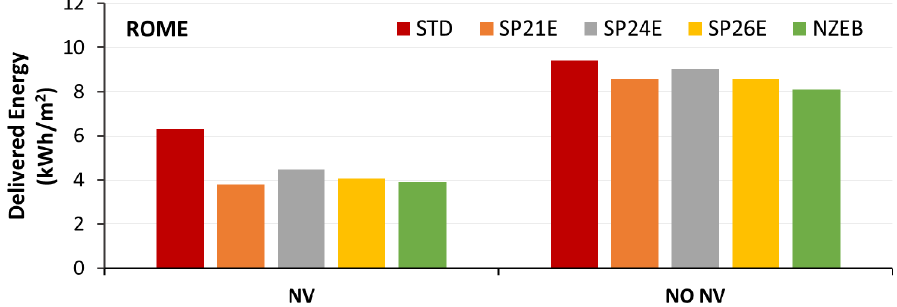
Figure 15. Delivered energy for cooling period for the three PCM tested in Rome compared to the STD and NZEB reference buildings, considering and not considering night ventilation.